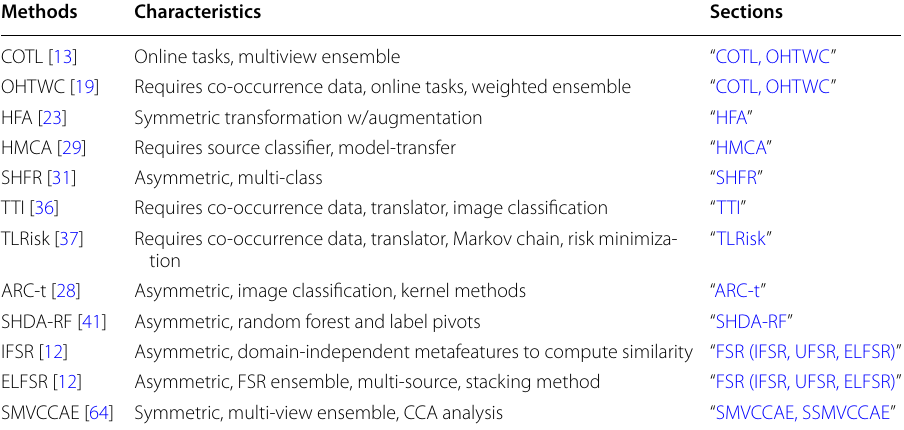
Table 1 Surveyed HTL methods which require limited target labels Methods